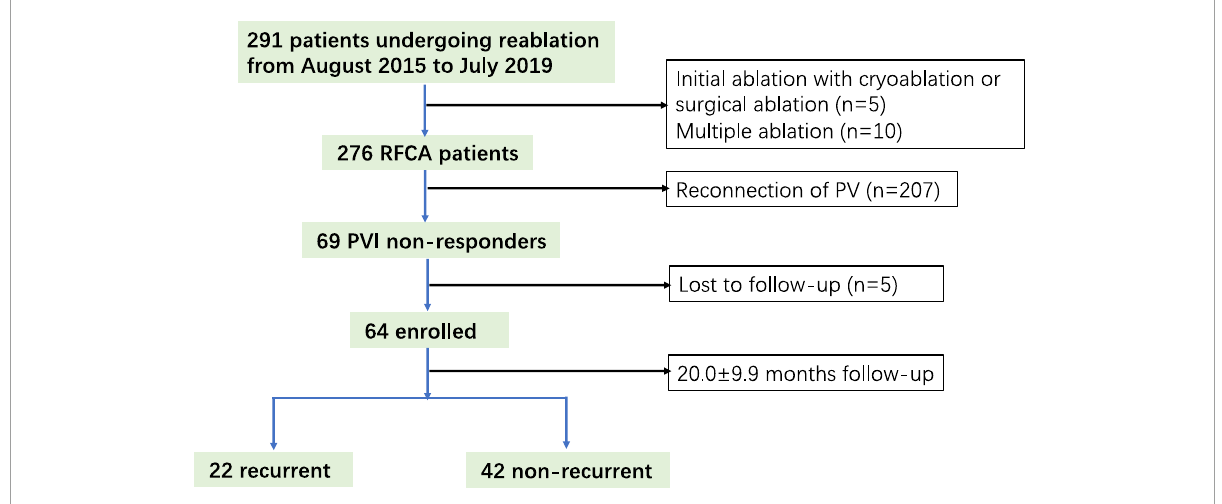
FIGURE1 Study flow diagram depicting the patient enrollment. RFCA, radiofrequency catheter ablation.